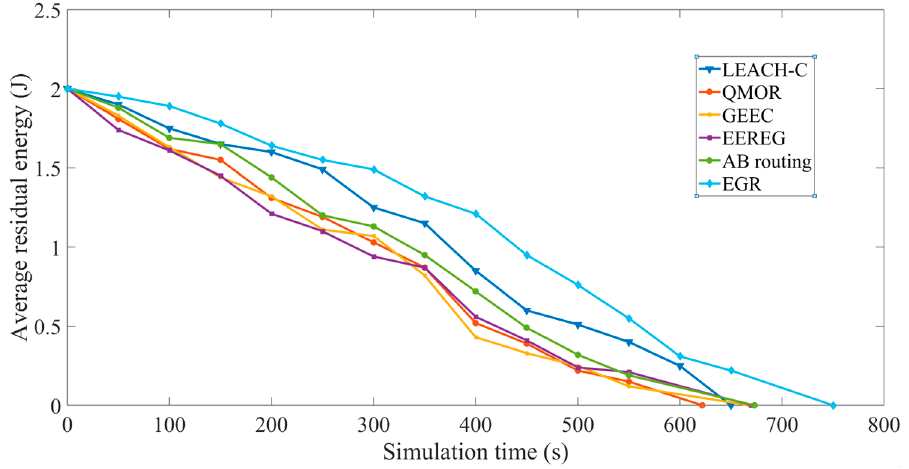
Figure 15. Average residual energy.